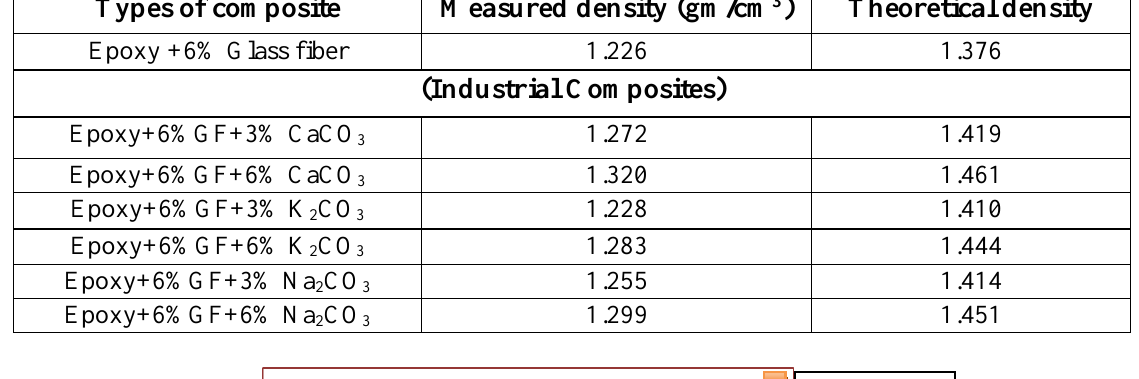
Table 2: Density of the prepared composites.